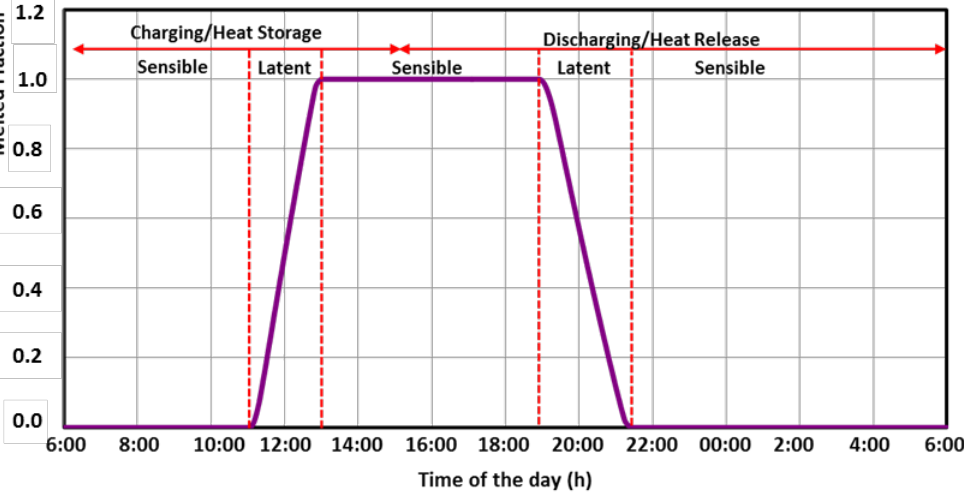
Figure 8. Time evolution of average melted fraction of the PCM during a complete cycle